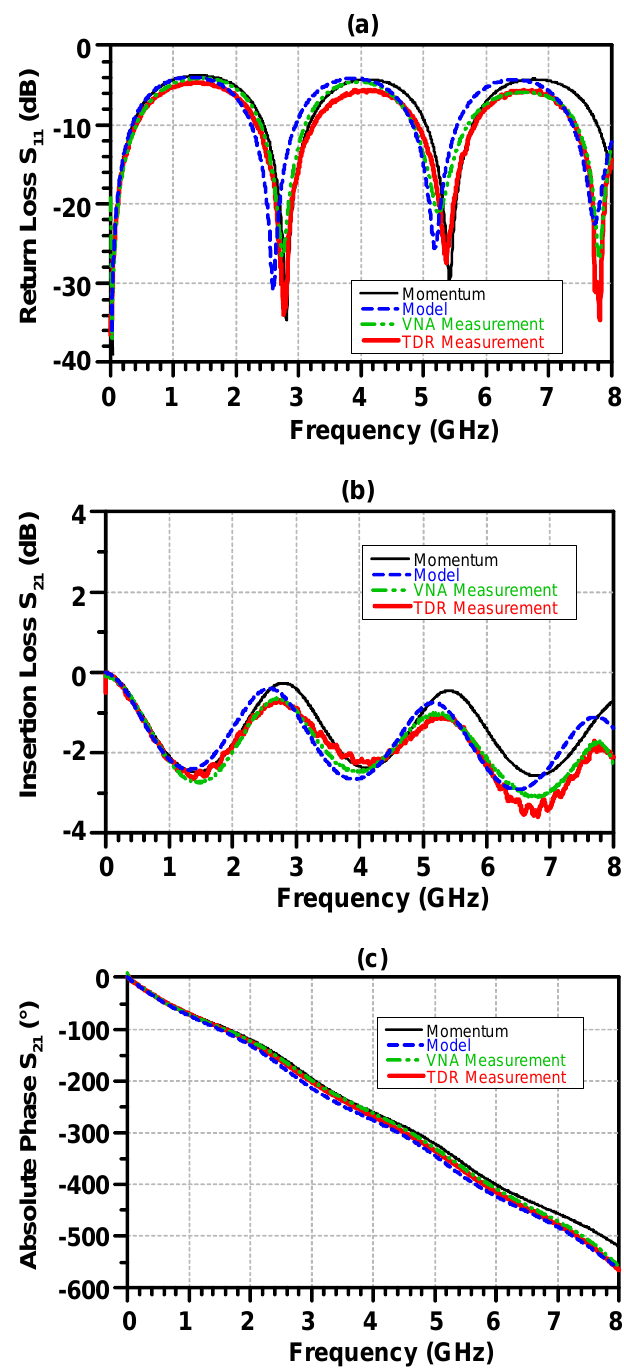
Figure 6: Comparisons of S 11 -amplitude (a) and S 21 - amplitude (b) and S 21 -phase (c) from the EM model obtained from momentum, the developed model, the VNA measurement and the TDR/TDT